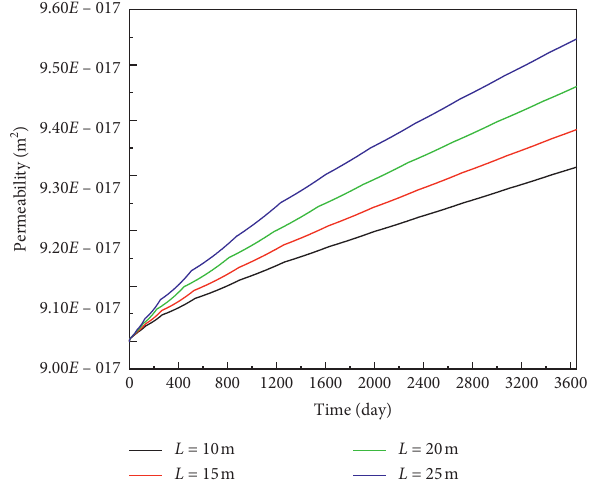
Figure 10: Variation of coalbed permeability with different frac- ture length at the reference point